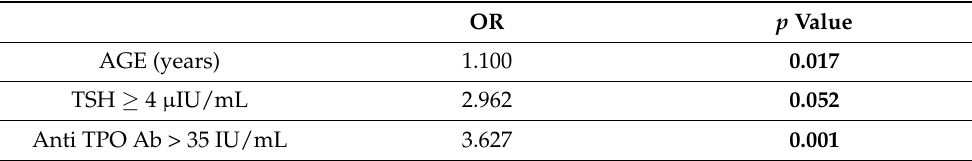
Table 8. Significant predictors of gestational diabetes